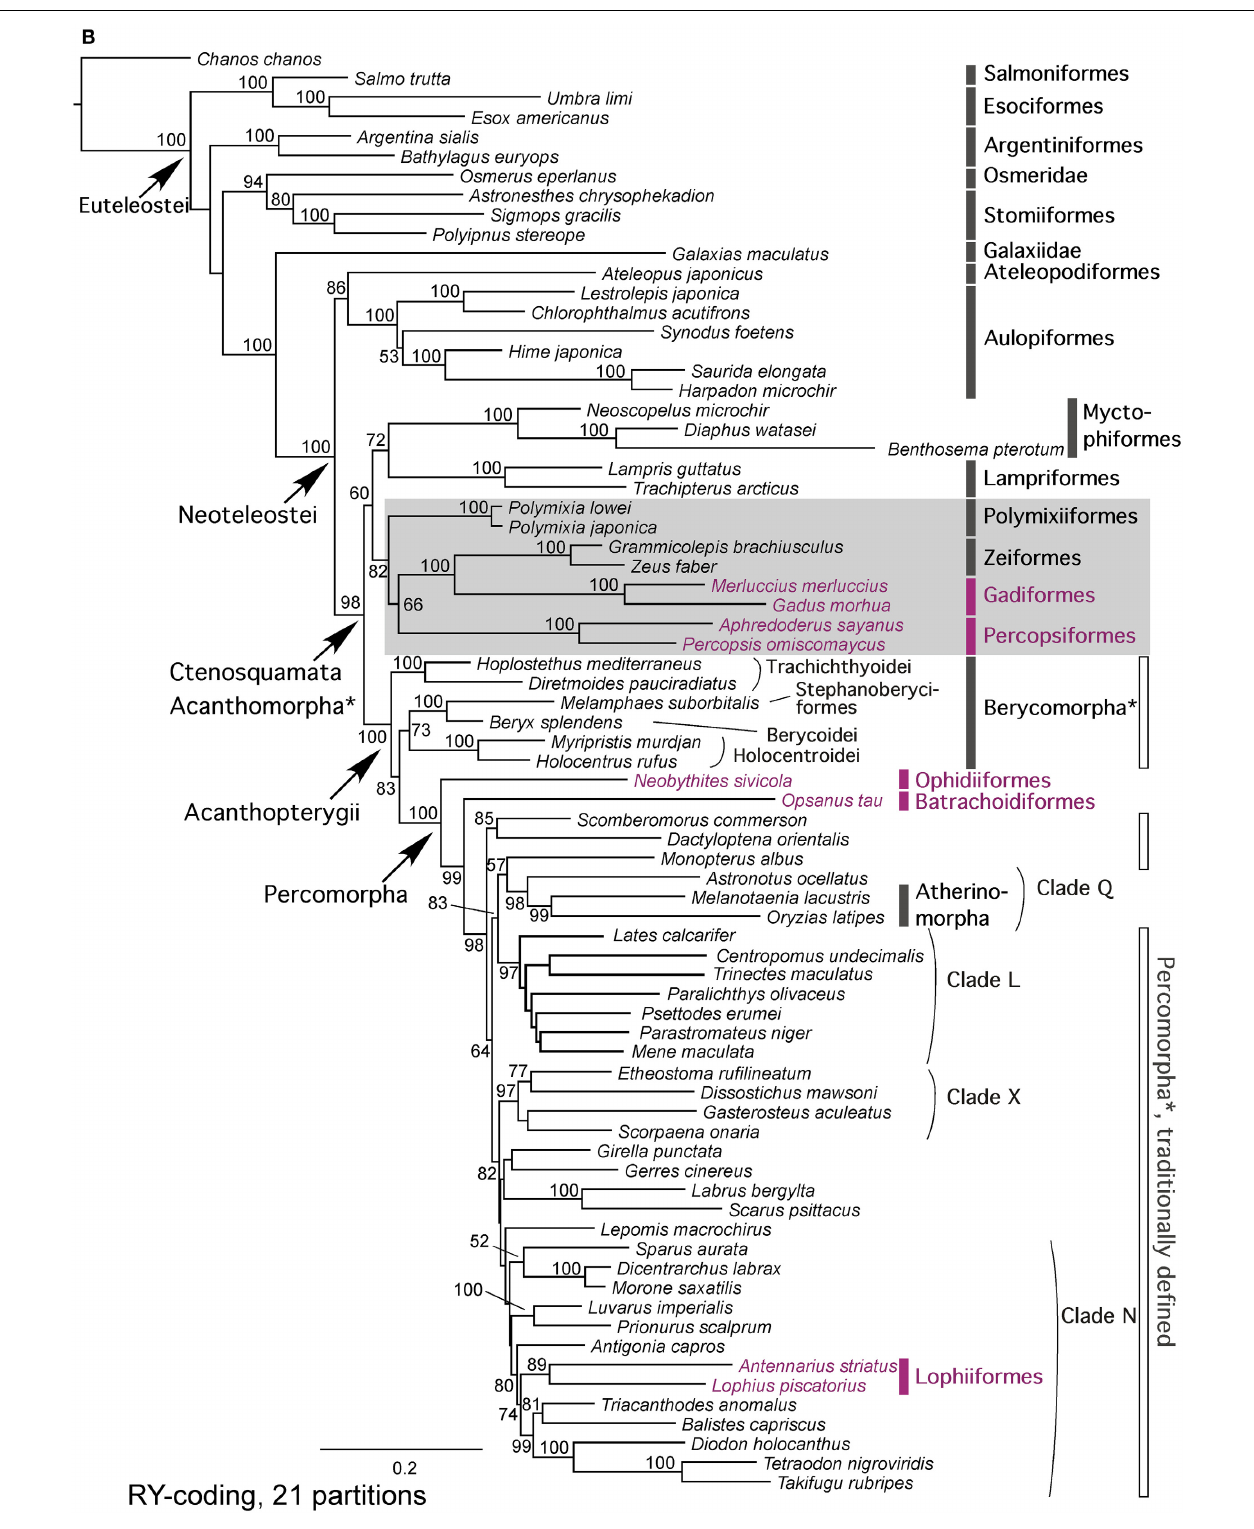
FIGURE 1 | Phylogenetic tree depicting evolutionary relationships of acanthomorph fishes and their putative sister-taxa within the Euteleostei. Relationships were inferred using partitioned maximum-likelihood (RAxML) analysis of 6967 aligned nucleotides from nine